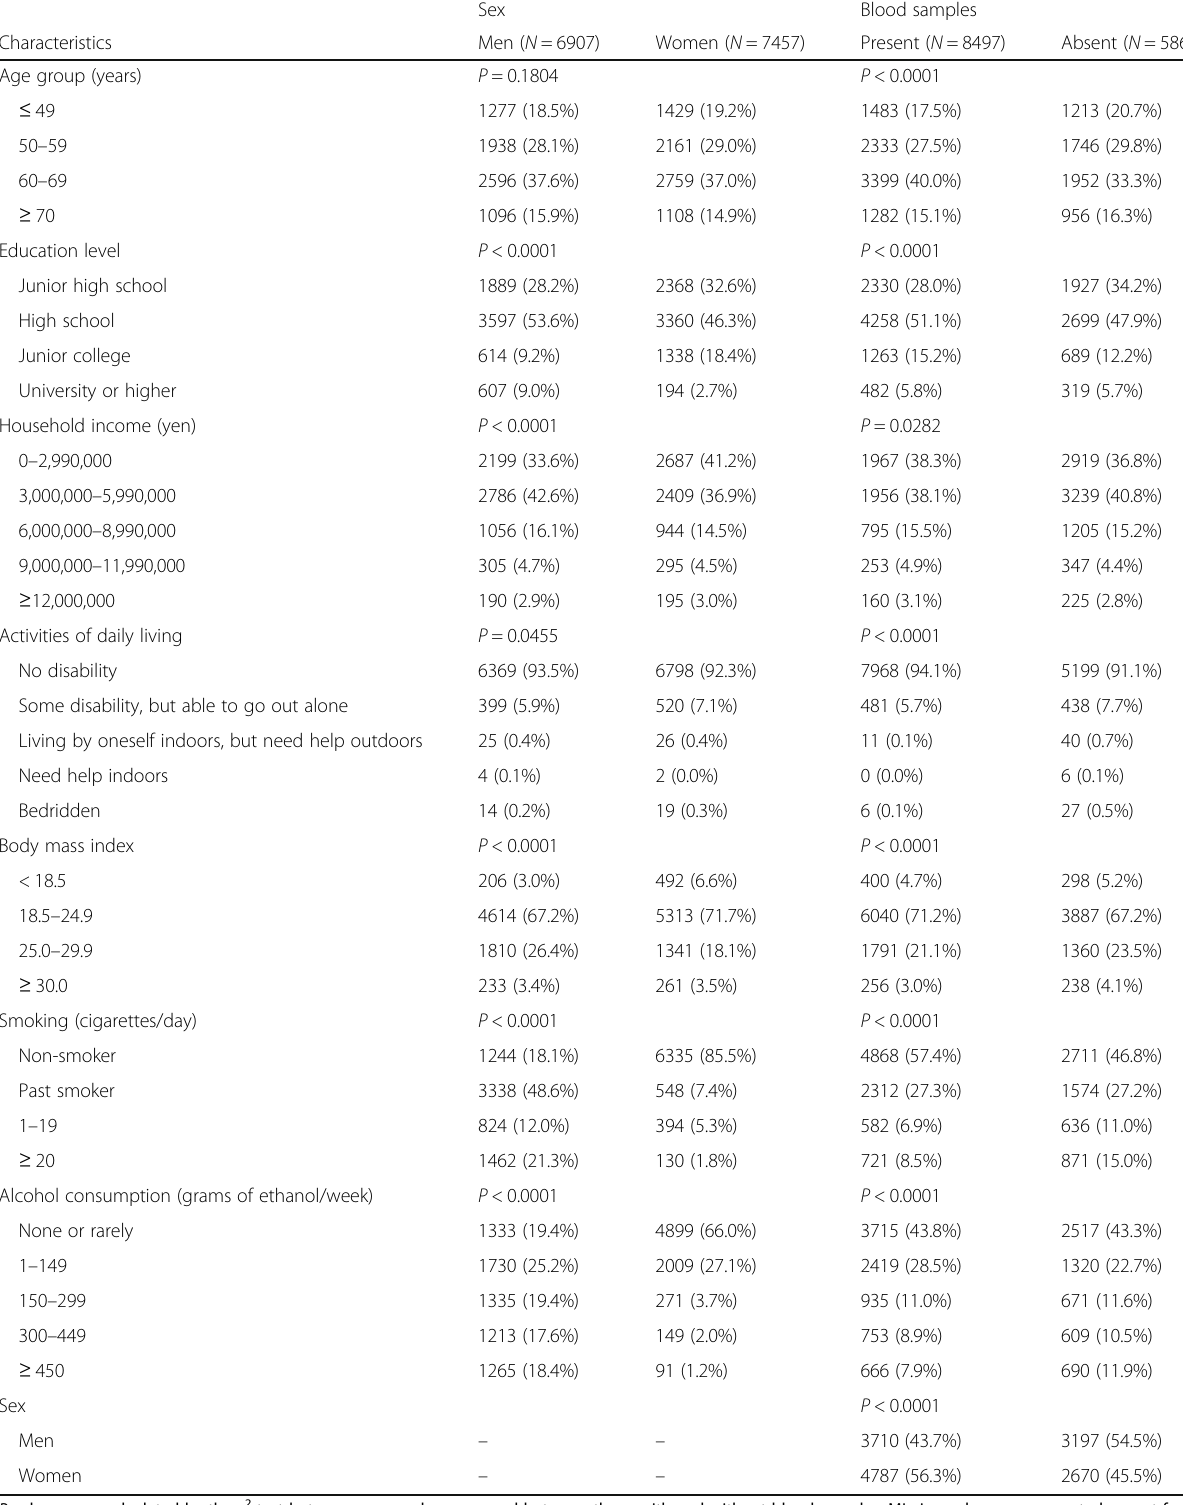
Table 2 Characteristics (numbers) of 14,364 participants by sex and blood sample